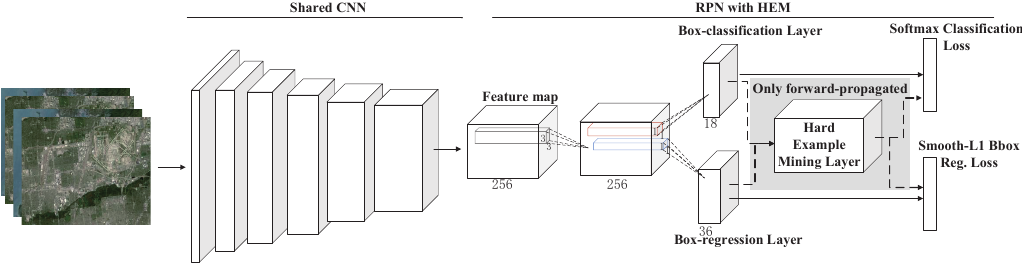
Figure 2. The framework of the RPN with hard example mining. The dotted line indicates that the data is only delivered in single direction along the arrow.